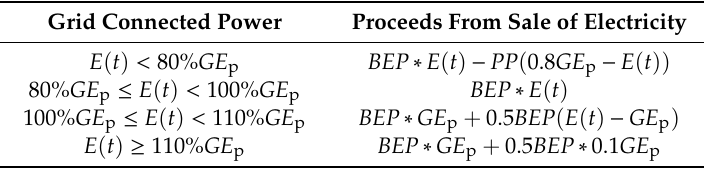
Table 4. The rules for selling electricity at peak time.